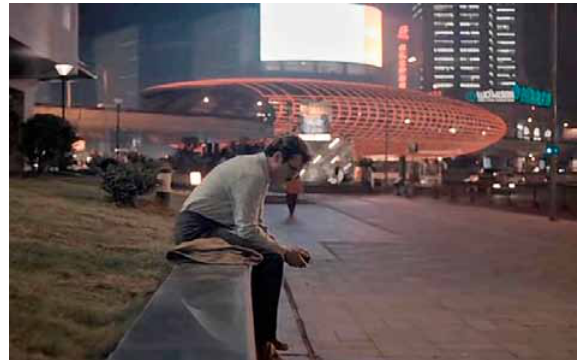
fig. 19. Her : Wujiaochang